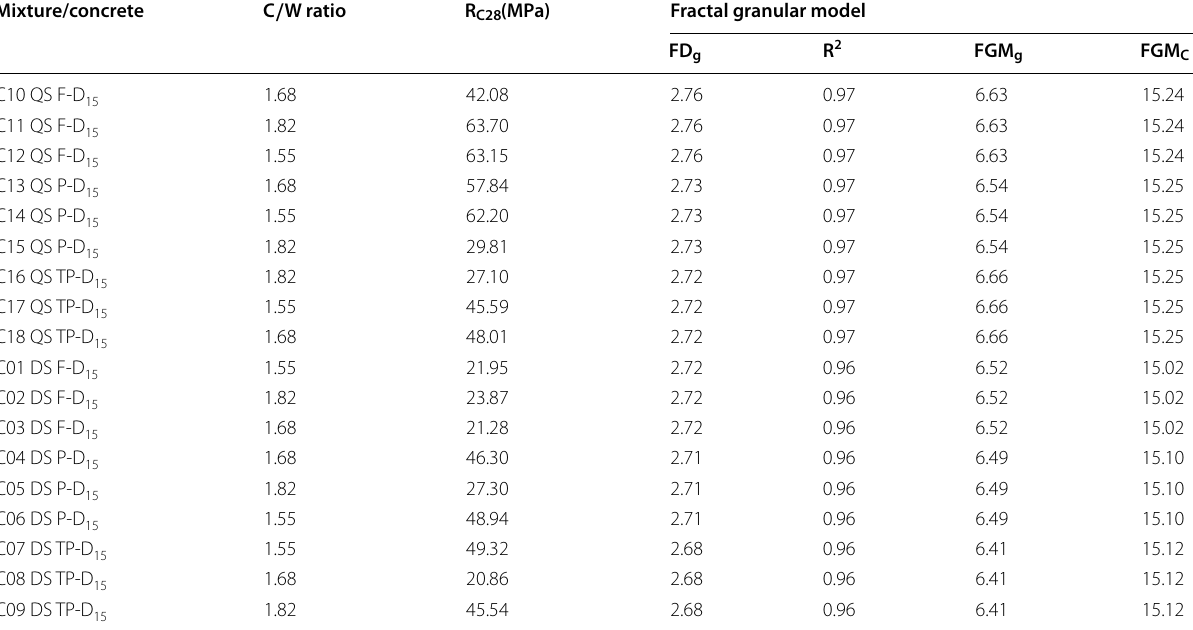
Table 6 Compressive strengths R C28 for concrete D 15 , and values of the granular fractal model.